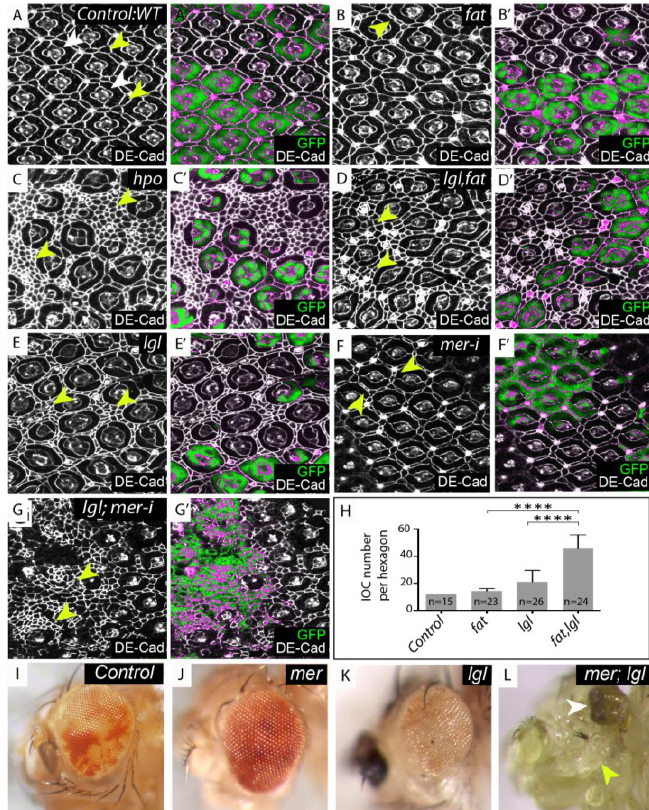
Figure 1. lgl regulates the Hippo (Hpo) pathway in parallel with fat and merlin . ( A – G ) Mosaic mid-pupal retinae stained with Drosophila E-cadherin (DE-Cad) antibodies that localize to the adherens junction and mark cell outlines. ( A – E ) mutant tissue lacks the expression of green fluorescent protein (GFP) and is merged with DE-Cad expression in ( A' – E' ). ( A ) Control, wildtype retina containing mosaic tissue expressing GFP and GFP negative tissue, white arrowheads denote photoreceptor and cone cells, yellow arrowheads denote IOCs; ( B ) Retina with fat −/− tissue or ( E ) lgl −/− tissue. The mutant area (GFP negative) shows a few extra IOC’s (yellow arrowheads); ( C ) hpo −/− clone (GFP negative); ( D ) lgl , fat −/− double mutant tissue (GFP negative) displays a substantial increase in IOC number (yellow arrowheads); ( F ) mer-RNAi depleted tissue (marked by the presence of GFP) shows a few additional IOC’s (yellow arrowheads); ( G ) lgl −/− ; mer-RNAi tissue (marked by the presence of GFP) display excess IOC’s (yellow arrowheads); ( H ) Mean number of IOCs per ommatidia. **** indicates p < 0.0001. Error bars represent Standard Deviation. n equals the number of ommatidia counted; ( I – L ) Adult male eye images; ( I ) Control, mosaic eye; ( J ) mer −/− , mosaic eye ( mer −/− tissue is pale red); ( K ) lgl −/− mosaic eye ( lgl −/− tissue is white); ( L ) mer ; lgl double mutant mosaic eye (note the decrease in adult retinal tissue (white arrowhead) and increase in head capsule tissue (yellow